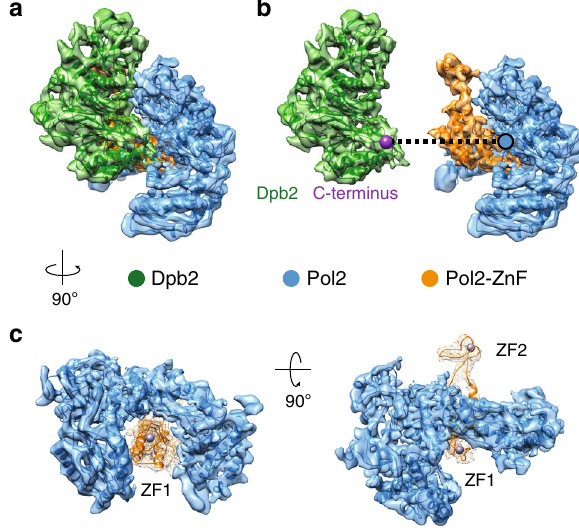
Fig. 2 Interaction between C-Pol2 and Dpb2. a Atomic model of C-Pol2 and Dpb2 built into the cryo-EM map. b Dpb2 C-terminus is poised towards the C-Pol2 interface, explaining why a truncation of the Dpb2 C-terminal region results in a lethal phenotype. c Pol2 zinc- fi nger appendix resides in the core of the Pol2 polymerase fold. This explains why a point mutation disrupting ZF1 is not compatible with viability. A second zinc- fi nger motif (ZF2) projects from the core of the complex